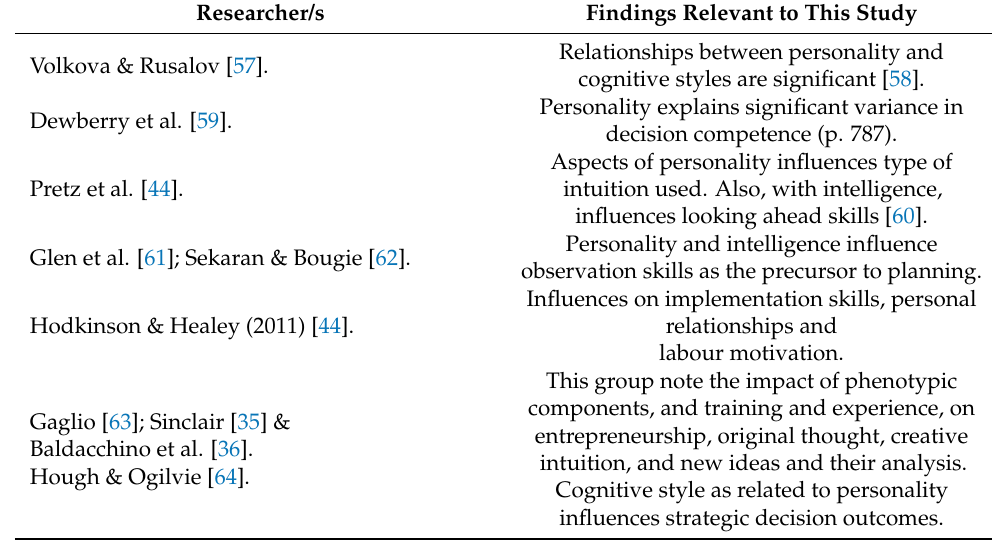
Table 2. Examples of research of phenotypic influences on cognitive intuition (‘objectively informed